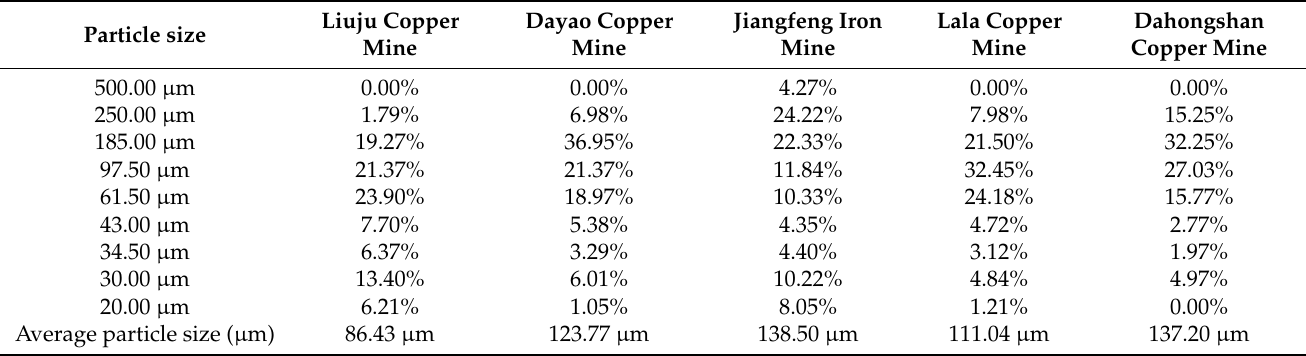
Table 1. Particle size distribution of different mine